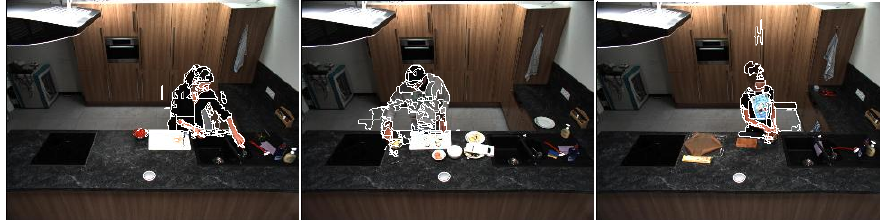
Figure 3. Results of the motion saliency region partition. The action categories of these three groups of images are “wash hands”, “put in bowl”, and